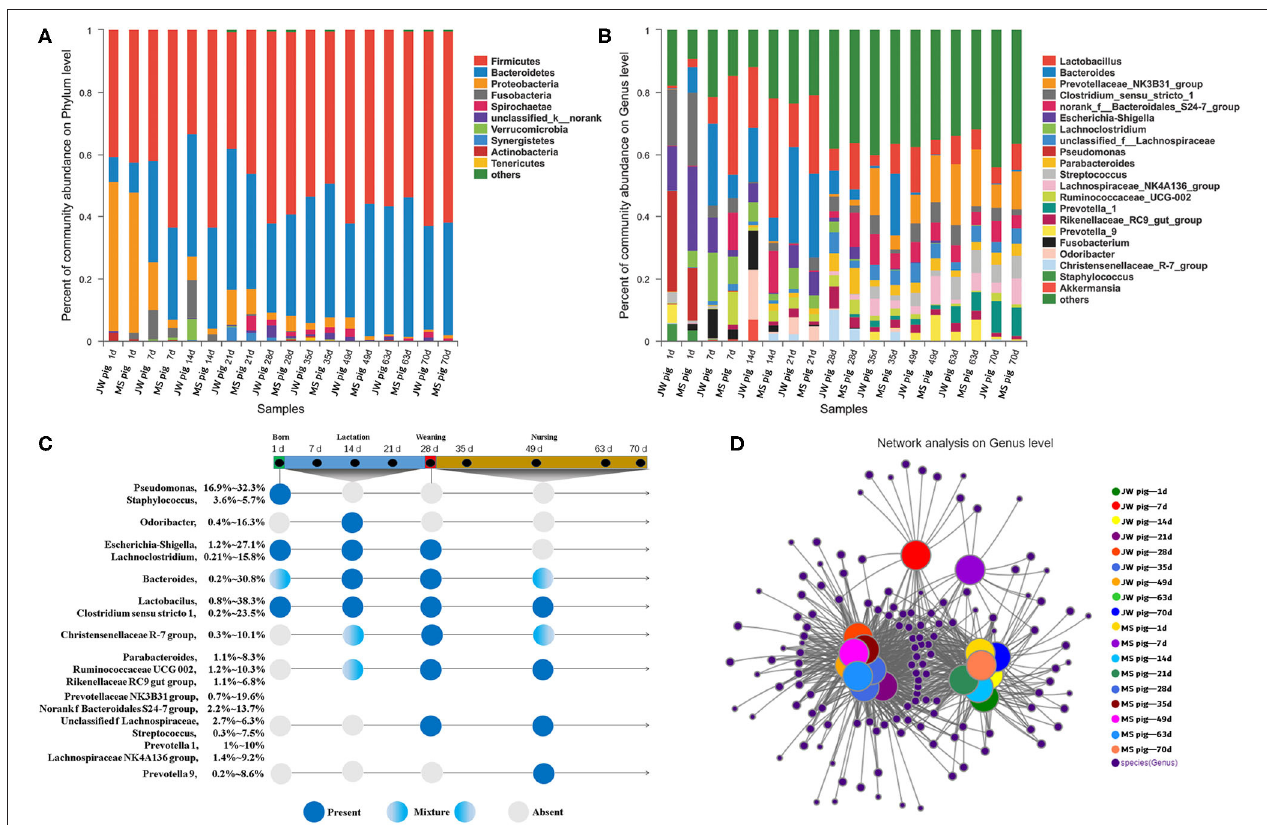
FIGURE 4 | Characterization of fecal microbiota from piglets. (A) Microbial community bar plot of phyla in piglet feces. (B) Microbial community bar plot of genera in piglet feces. (C) Longitudinal patterns in piglet fecal microbiomes based on averaged relative abundances according to days after birth. (D) Network analysis of microbial co-occurrences in piglet